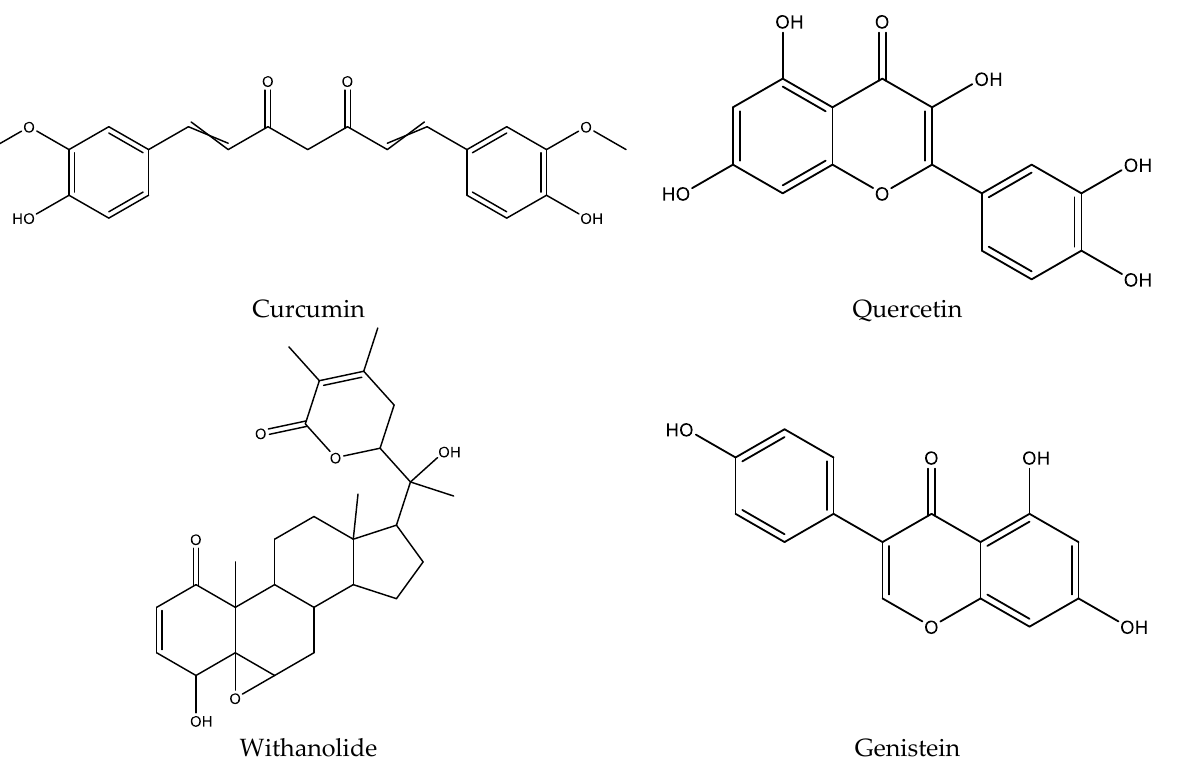
Figure 1. The chemical structures of curcumin, quercetin, withanolide, and genistein.